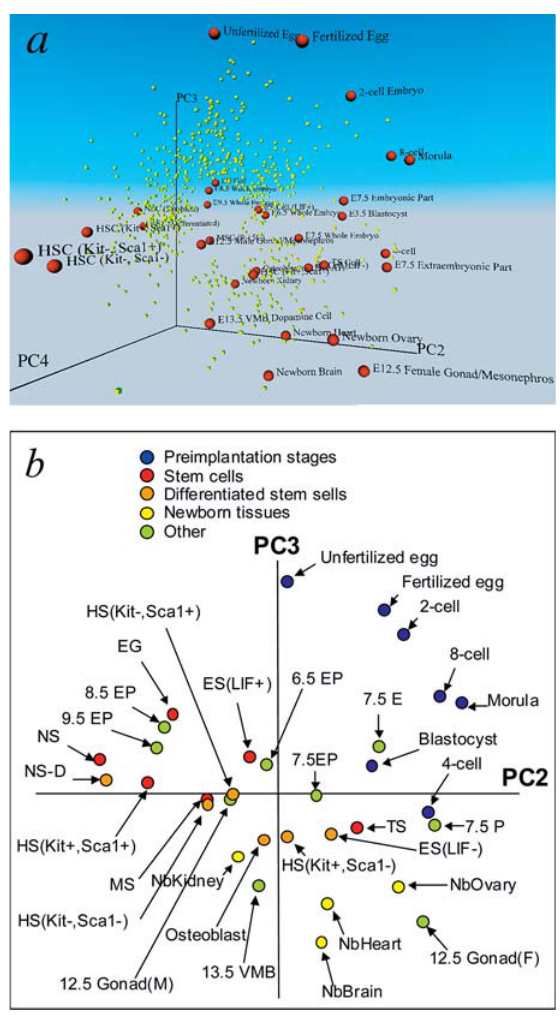
Figure 4. PCA Analysis of EST Frequency The results were obtained by analyzing 2,812 genes that exceeded 0.1% in at least one library. (A) 3D biplot that shows both cell types (red spheres) and genes (yellow boxes). (B) 2D PCA of cell types. EST frequencies were log-transformed before the analysis. Names of some cells and tissues are abbreviated as follows: 6.5 EP, E6.5 whole embryo (embryo plus placenta); 7.5 EP, E7.5 whole embryo (embryo plus placenta); 8.5 EP, E8.5 whole embryo (embryo plus placenta); 9.5 EP, E9.5 whole embryo (embryo plus placenta); 7.5 E, E7.5 embryonic part only; 7.5 P, E7.5 extraembryonic part only; NbOvary, newborn ovary; NbBrain, newborn brain; NbHeart, newborn heart; NbKidney, new- born kidney; 13.5 VMB, E13.5 ventral midbrain dopamine cells; 12.5 Gonad (F), E12.5 female gonad/mesonephros; 12.5 Gonad (M), E12.5 male gonad/mesonephros; HS (Kit (cid:1) , Sca1 (cid:1) ), hematopoietic stem/ progenitor cells (Lin (cid:1) , Kit (cid:1) , Sca1 (cid:1) ); HS (Kit (cid:1) , Sca1 þ ), hematopoietic stem/progenitor cells (Lin (cid:1) , Kit (cid:1) , Sca1 þ ); HS (Kit þ , Sca1 (cid:1) ), hemato- poietic stem/progenitor cells (Lin (cid:1) , Kit þ , Sca1 (cid:1) ); HS (Kit þ , Sca1 þ